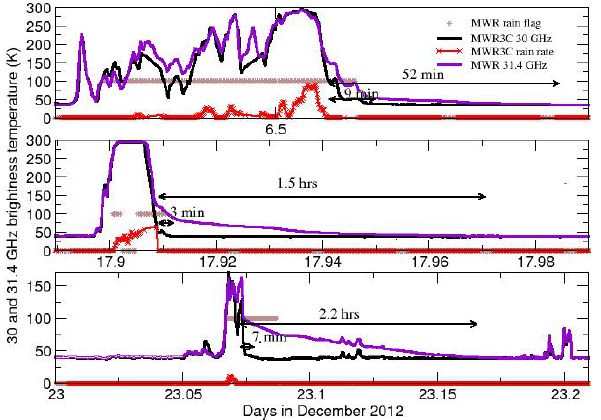
Fig. 8. Brightness temperatures collected at six time intervals from the end of rain events. Data are collected at the SGP, GAN, and TWP sites during the months of November and December